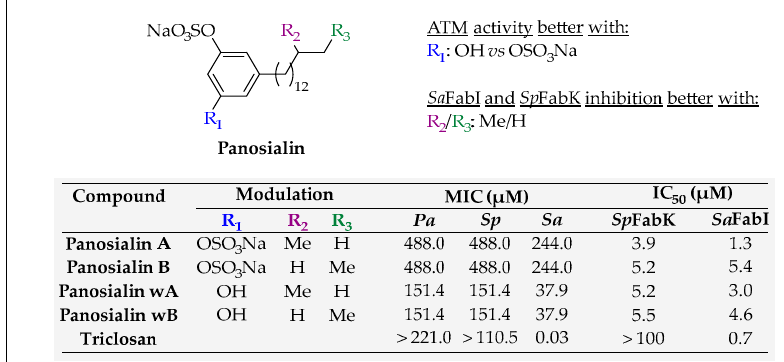
Figure 41. Structure, SAR and in vitro activities of panosialins A , B , wA and wB [170].